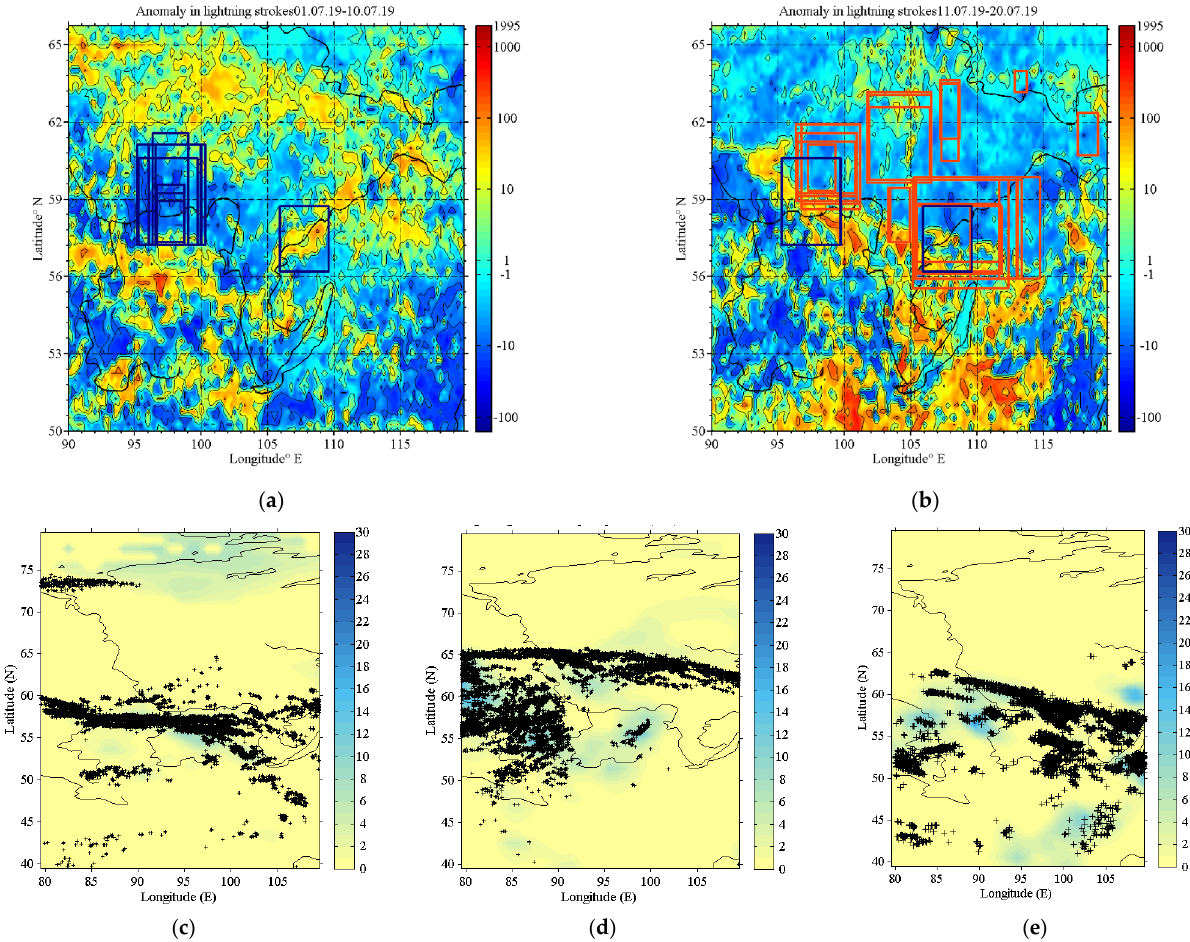
Figure 14. Anomaly in lightning strokes compares to periods 2009–2018 ( a );1–10 July 2019 ( b );10–20 of July 2019. The total amount of lightning strokes and precipitation on 2 ( c ), 6 ( d ), 17 ( e ) July. Thunderstorms that occur without significant rainfall on the ground are called “dry thunderstorms” (DTh) [73,74]. DTh are the most dangerous in the case of dry soil and atmospheric conditions. More importantly, dry thunderstorm events often lead to large wildfire outbreaks [73]. The increase in DTh during blocking can be explained by the in- crease in the vertical instability of the atmosphere. The instability is associated with the formation of cutoff filaments with a low potential temperature (or high PV) [73]. The ex- ample on 17 July shows that the increase in DTh during blocking can be explained by the vertical instability of the atmosphere (Figure 10a) and high near-surface temperature (Fig- ure S2b). In Figure S2a, CAPE (convective available potential energy) is shown, which characterizes the amount of energy available for convection in the atmosphere. The com- bination of instability and high surface temperatures is due to the configuration of the cyclonic breaking on 17 July. The estimates of the effect of LS on fires and the ratio of their contribution require additional research. In the present paper, we only draw attention to the increase in the number of dry thunderstorms during the 2019 blocking periods. Additionally, our find- ings are in agreement with the statement made by the Krasnoyarsk Forest Fire Center. 3.3. Factors that Affected the Magnitude of Forest Fire Intensity (Hotspot Number and Emission) We have shown that forest fire periods in 2019 are strongly associated with wave breaking and atmospheric blocking. Both breaking and blocking caused the positive sur- face temperature anomalies in Northern Siberia (Figure 1b). There are three main effects of surface temperature increase linked to breaking and blocking anticyclone formation. The first effect is the transport of air masses from lower latitudes [75,76], which is indi- cated by high PV- Θ values on the maps. The second effect is the adiabatic warming in the upper-level anticyclone, caused by the subsidence of air parcels [77]. Additionally, the downward motion anomalies associated with blocking anticyclones result in less cloud cover and increased incoming solar radiation. The latter also contributes to an increase in surface temperature [50]. Ponomarev et al. (2016) [3] demonstrated the significant rela- tionship between forest fire characteristics in Siberia, surface temperature, and incoming solar radiation. Thus, regardless of the contribution of the three factors, we evaluated the role of wave breaking and blocking as crucial drivers of surface temperature anomalies in summer 2019. However, it is necessary to investigate the other effects of blocking in Siberia, which contribute to the maximum magnitude of CO emissions and hotspot count (Figure 1a): atmospheric moisture and wind speed [75,76]. Therefore, we analyzed the variations in the total atmospheric moisture content and wind speed during July-August (two critical